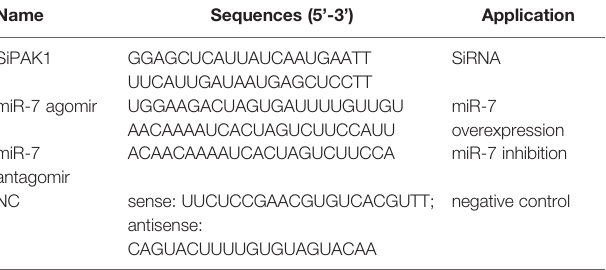
TABLE 2 | Synthetic sequences used in this